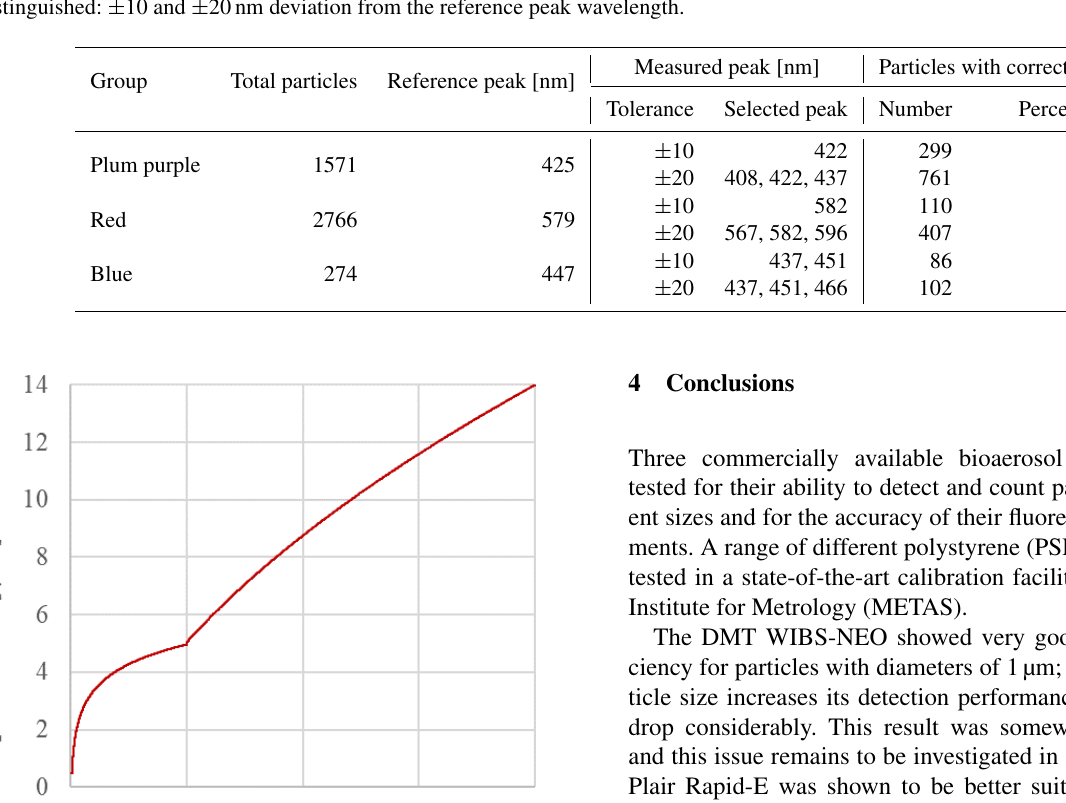
Table 4. Number and percentage of particles with “almost correct” fluorescence peak position measured by the Rapid-E. Two cases are distinguished: ± 10 and ± 20nm deviation from the reference peak wavelength.